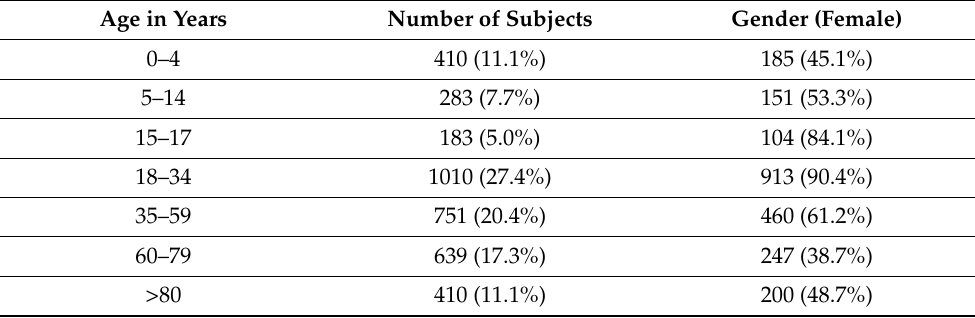
Table 2. Age distribution of the patients ( n = 3686).